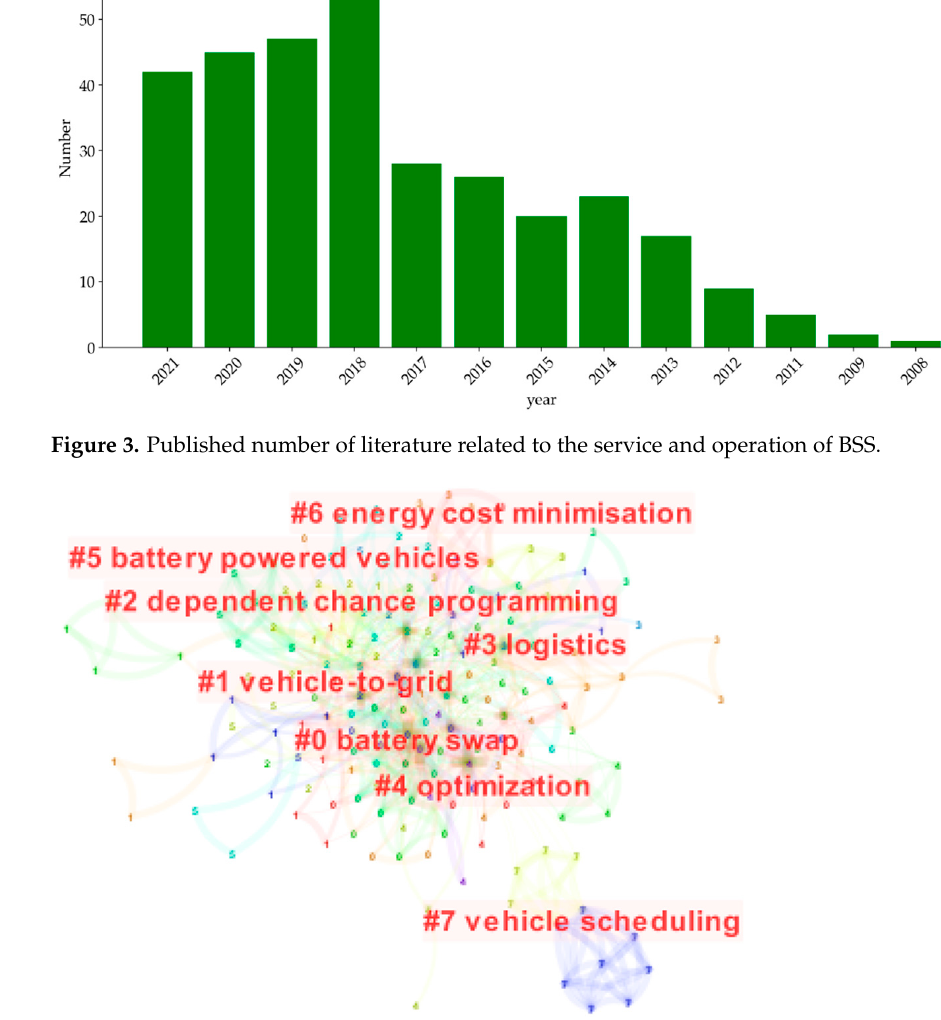
Figure 4. Cluster analysis of keywords in related literature on power